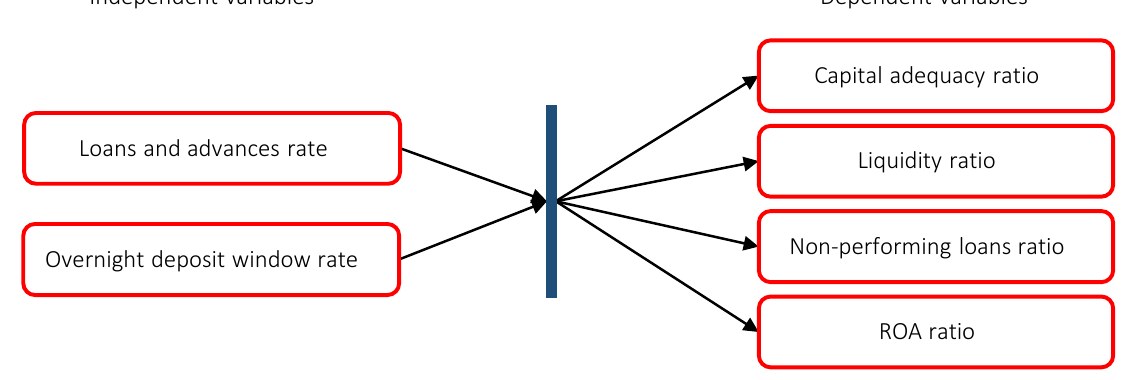
Figure 1. Model of the study